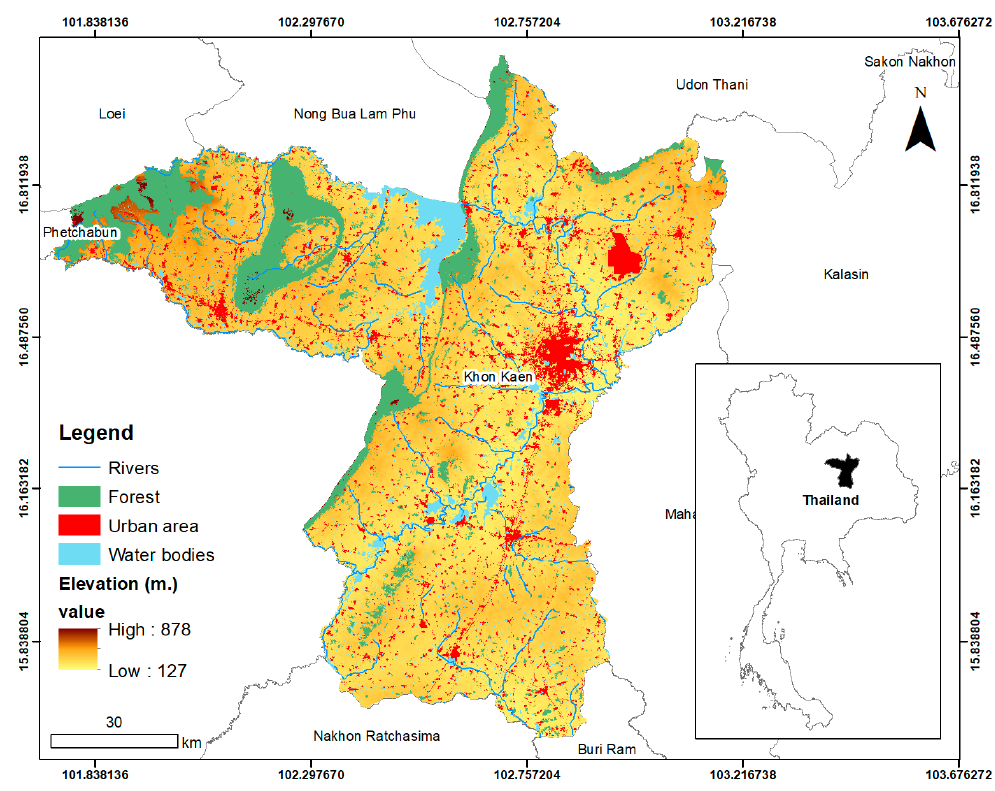
Figure 1. Location of the study area in Khon Kaen, Thailand (data source: Land Development Dept. 2020; SRTM DEM).